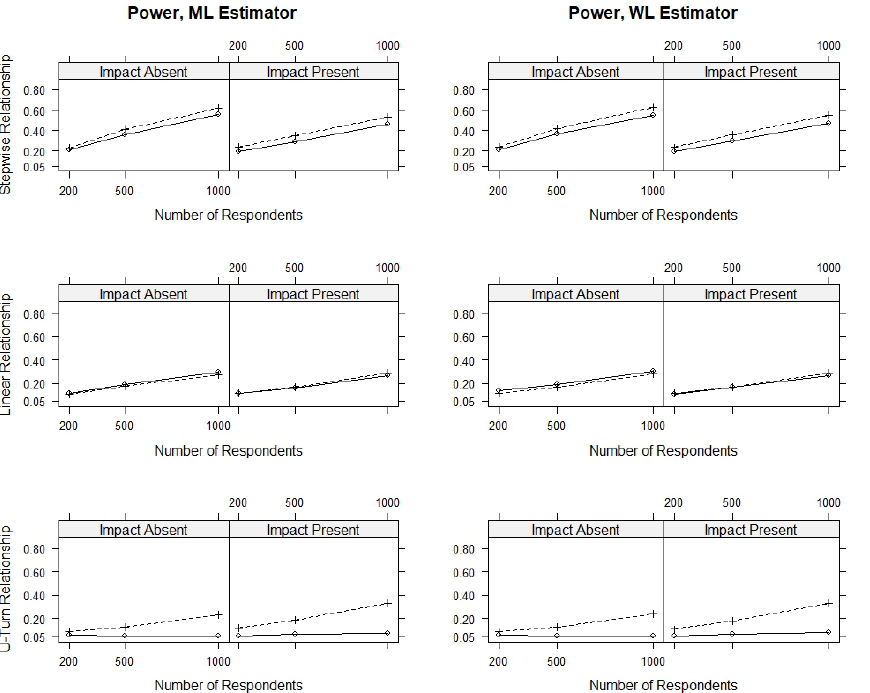
Figure A1. Power of two tests against balanced DIF in the β parameter for modules of 9 items. All items are used for ability estimation. The unbroken line presents the results for the linear logistic regression test, the broken line presents the results for the score-based bootstrap test.